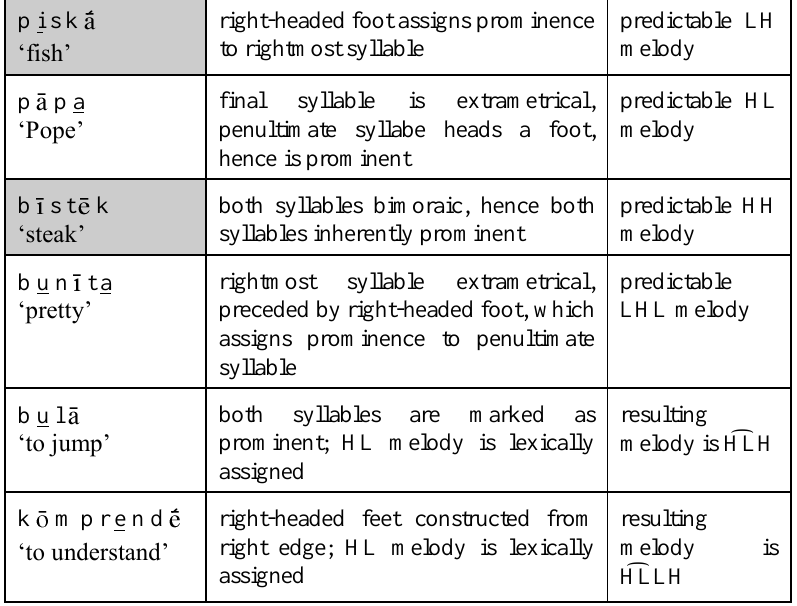
Table 5. Derivation of Pp words, after Devonish & Murray